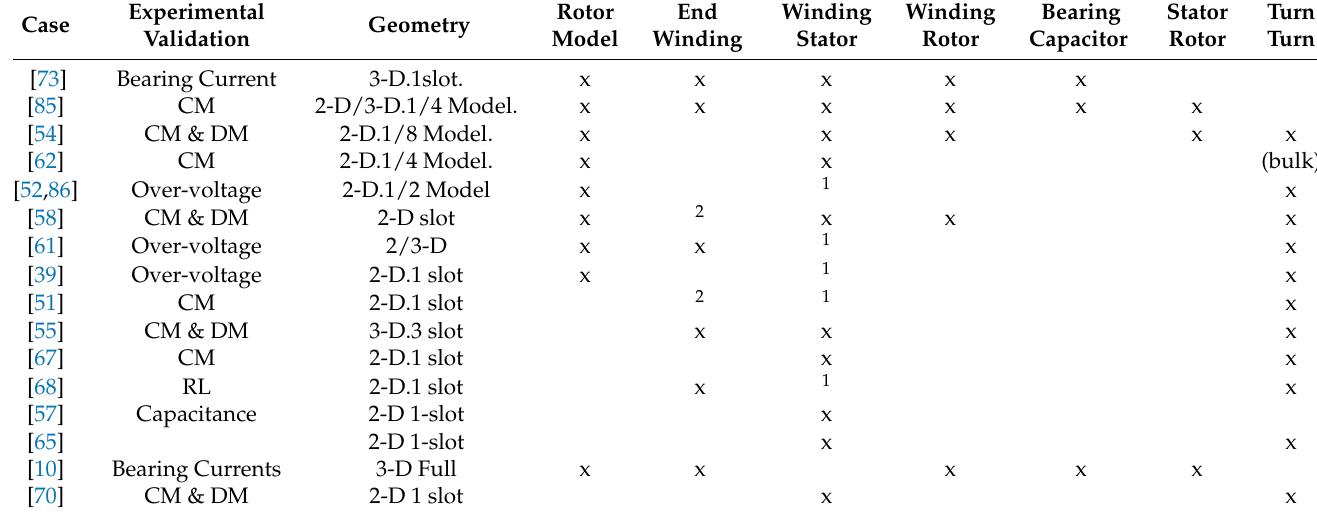
Table 2. FEM Electrostatic